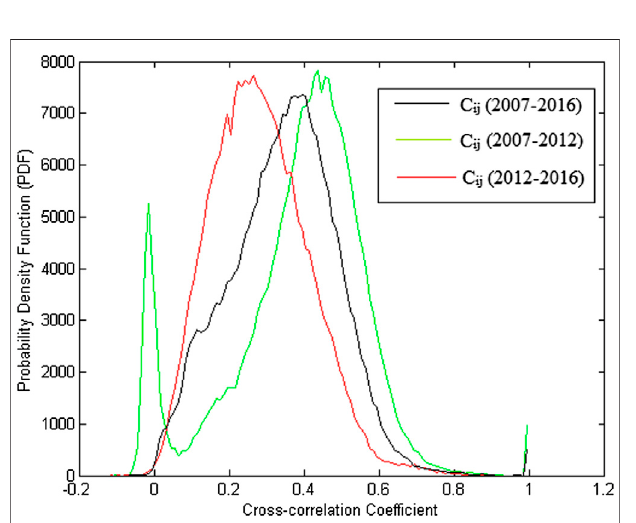
FIGURE 1 | Flowchart of the simulated annealing (SA) algorithm to form a block diagonal matrix (BDM). The most stable BDM is obtained when the energy in the system is of the minimum value. To fi nd the most stable BDM and avoid the local minimum, we propose to combine it with simulated annealing, bringing the concept of annealing to the formation of crystals in optimization problems.